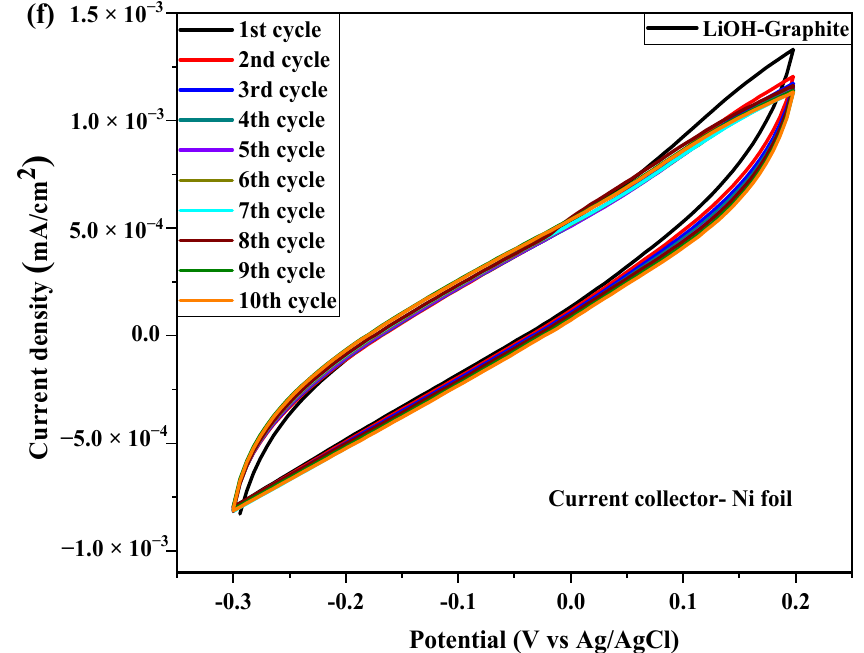
Figure 9. Cyclic voltammetry (CV) test of (current collector-Cu foil and Ni foil and 5% KOH electrolyte) under 10 cycles ( a ) LiOH-YP80F with Cu-foil; ( b ) LiOH-YP80F with Ni-foil; ( c ) LiOH-YP50F with Cu-foil; ( d ) LiOH-YP80F with Ni-foil; ( e ) LiOH-Graphite with Cu-foil; ( f ) LiOH-Graphite with Ni-foil.